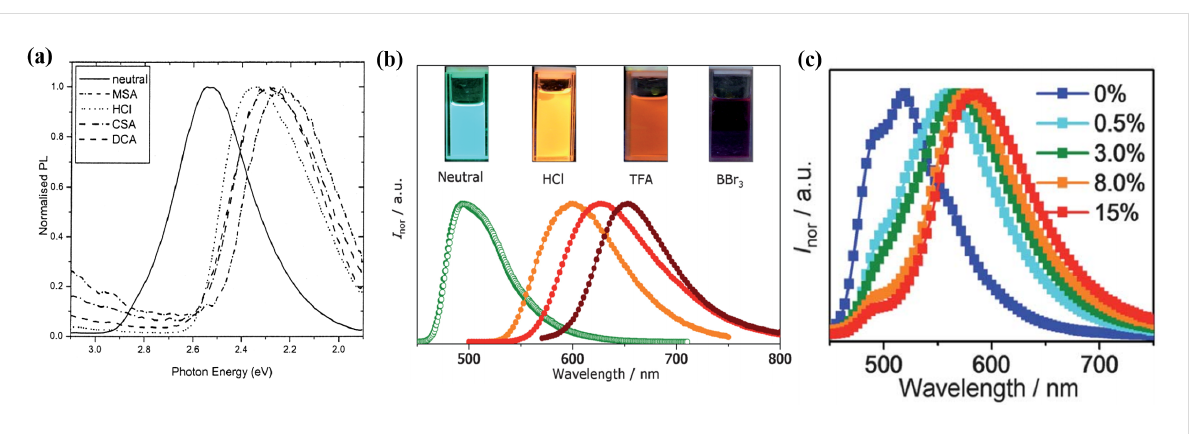
Figure 3: (a) Normalized PL spectra of films with compound 1 doped with different Lewis acids. (b) PL spectra of compound 2 under different acid conditions in dichloromethane. (c) EL spectra of devices with compound 2 doped with CSA at different concentrations. Figure 3a was reprinted with permission from [26], Copyright 2002 American Chemical Society. This content is not subject to CC BY 4.0. Figure 3b and 3c were reproduced from [27] with permission from The Royal Society of Chemistry. This content is not subject to CC BY